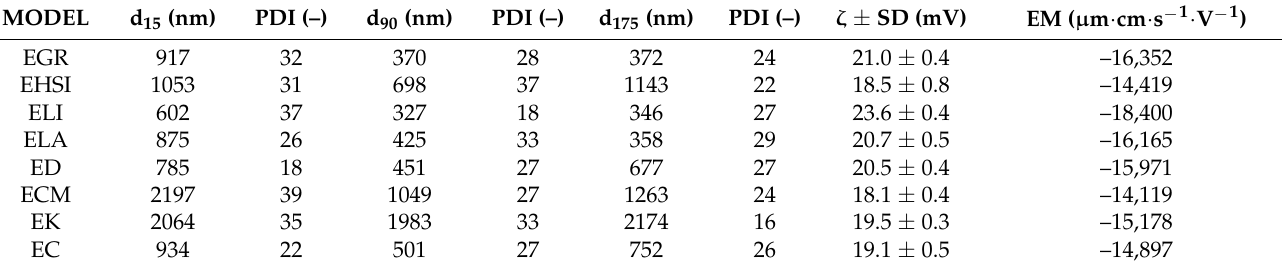
Table 1. Hydrodynamic diameter and zeta potential of modelled calcium powders.